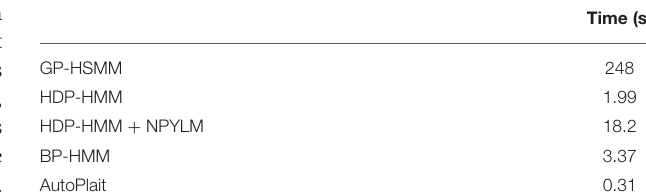
TABLE 3 | Computational time of each method.